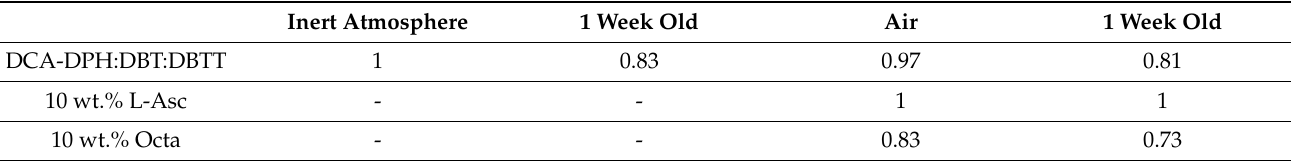
Table 3. PL QY values of as-prepared samples (either prepared in an oxygen-free atmosphere or in air) and after one week of air and light exposure, with and without